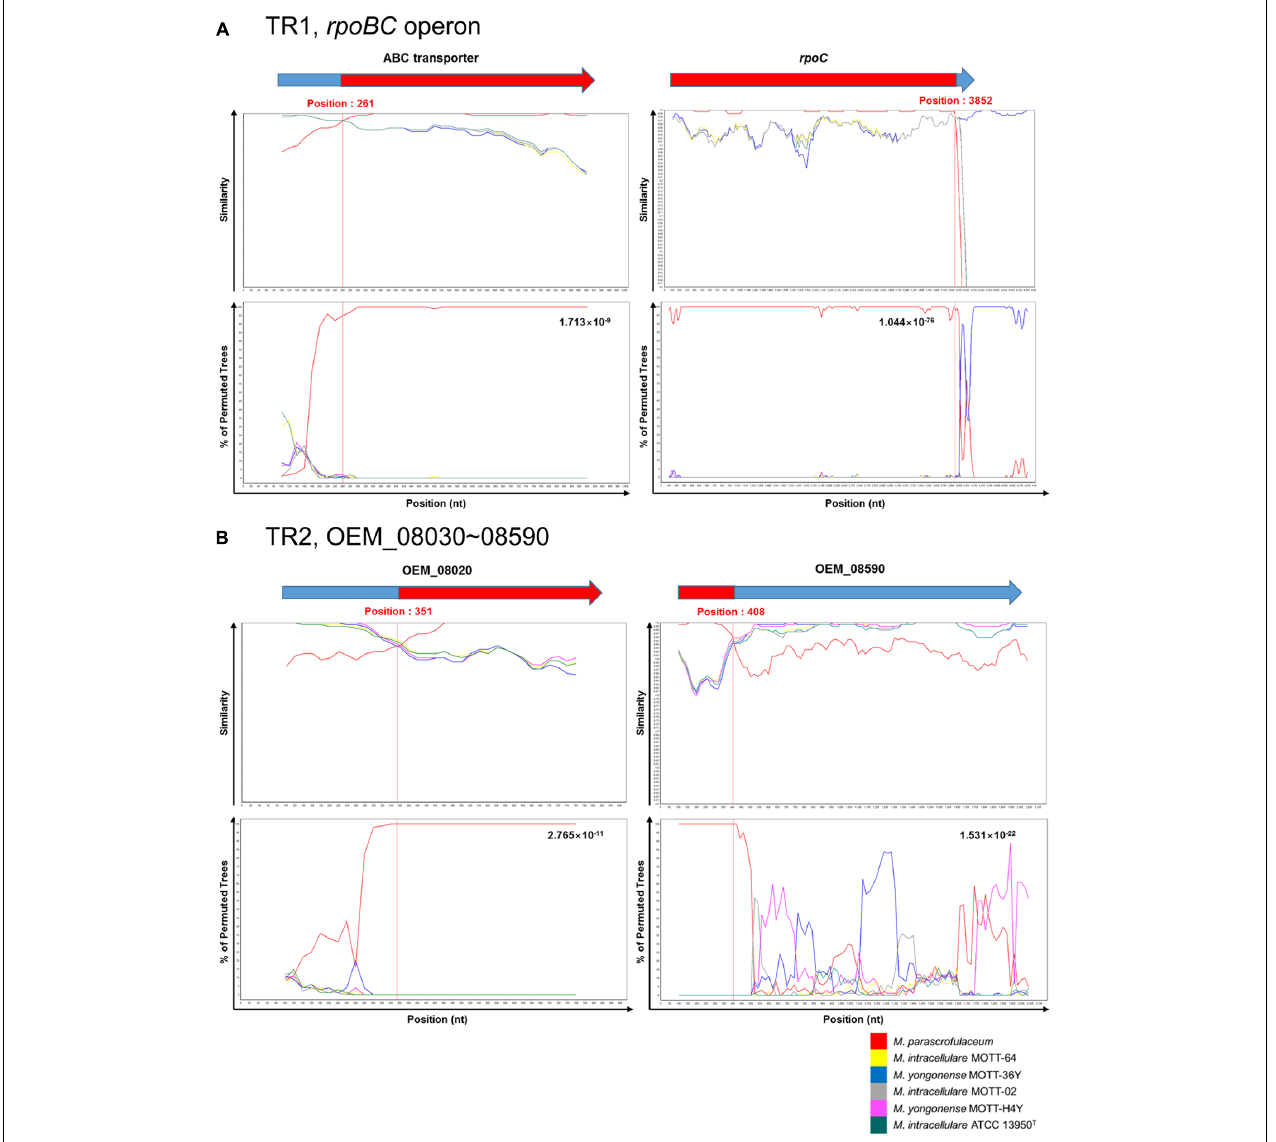
FIGURE 2 | Plots of similarity in a putative recombination site from M. intracellulare (ATCC 13950 T , MOTT-02 and MOTT-64) or M. yongonense Type II (MOTT-36Y and MOTT-H4Y) and M. parascrofulaceum strains to M. yongonense Type I (DSM 45126 T , MOTT-12 and MOTT-27) strains. (A) First recombination site